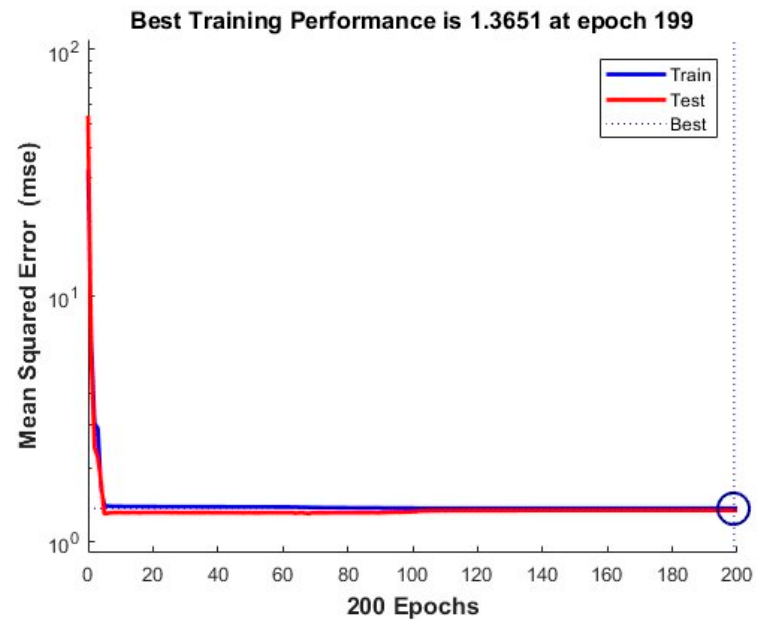
Figure 19. Performance analysis of the neural network (wind velocity forecasting case).